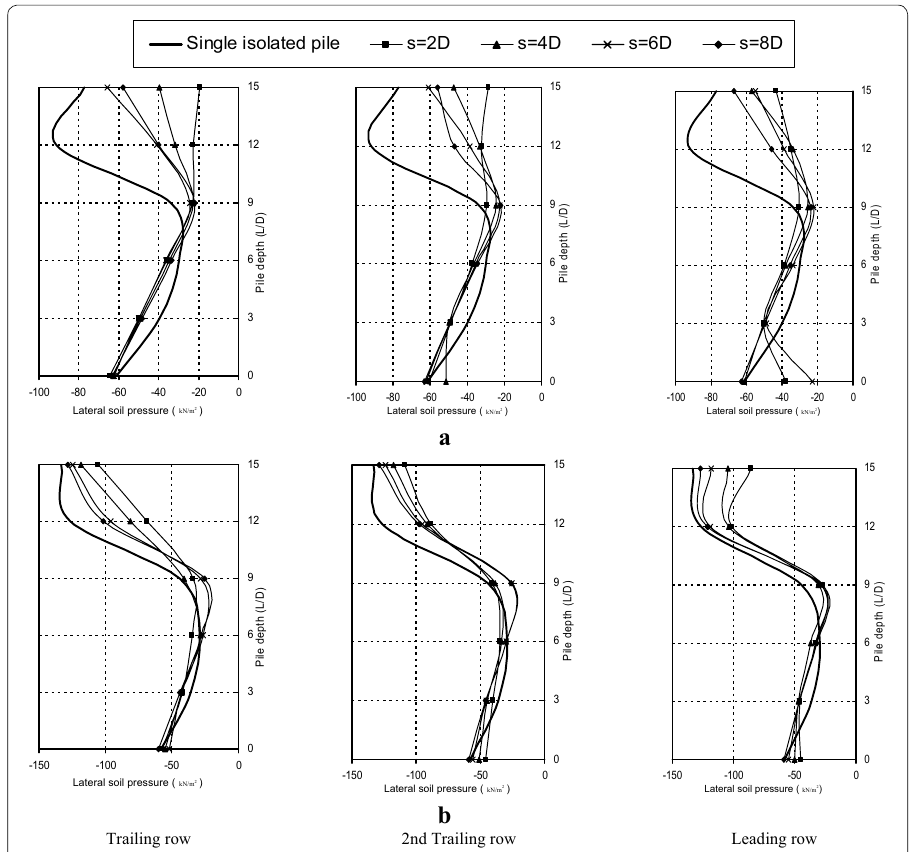
Fig. 7 Influence of pile spacing on the lateral soil pressure with depth of group piles (3 soil and b cohesive